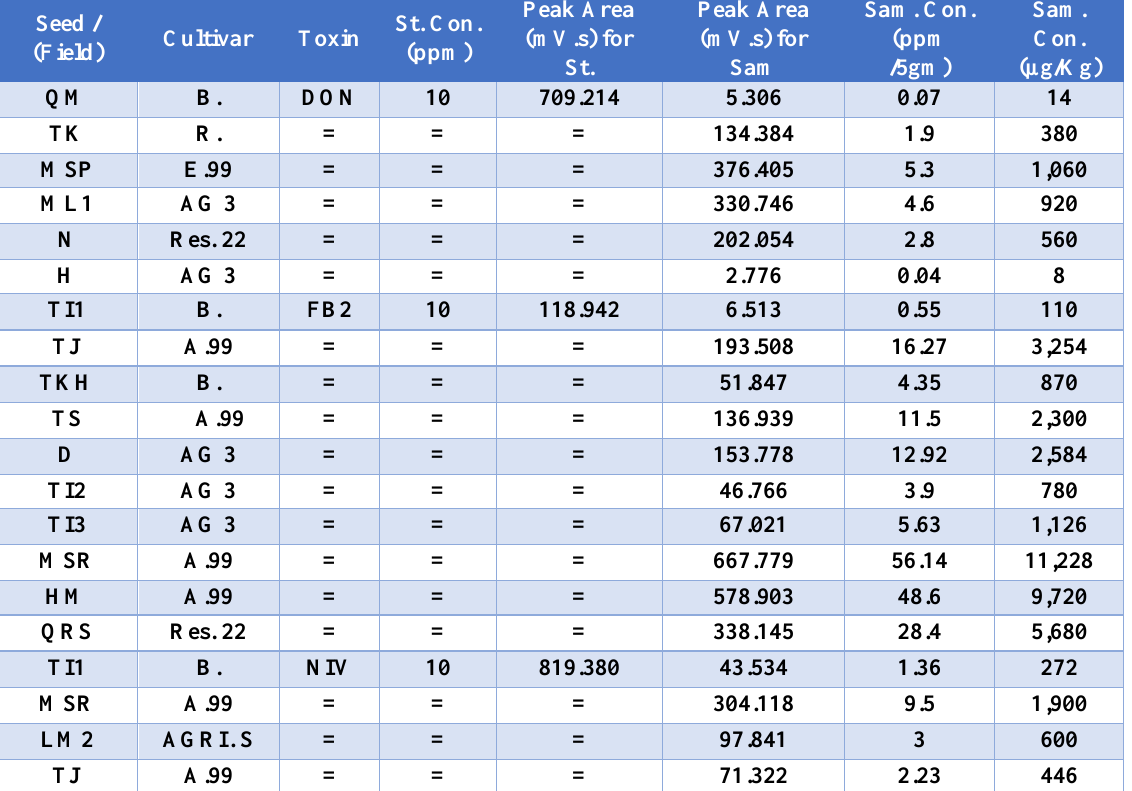
Figure, 4: HPLC chromatogram presented peak detection by absorbance at l = 220 nm and peak spectra for Fumonisine B2 and Nivalenol (NIV) concentrations in wheat seeds in ppm/ 5gm. Table,1: Myco-toxins concentration rates in wheat seeds obtained by HPLC analysis using chromatographic